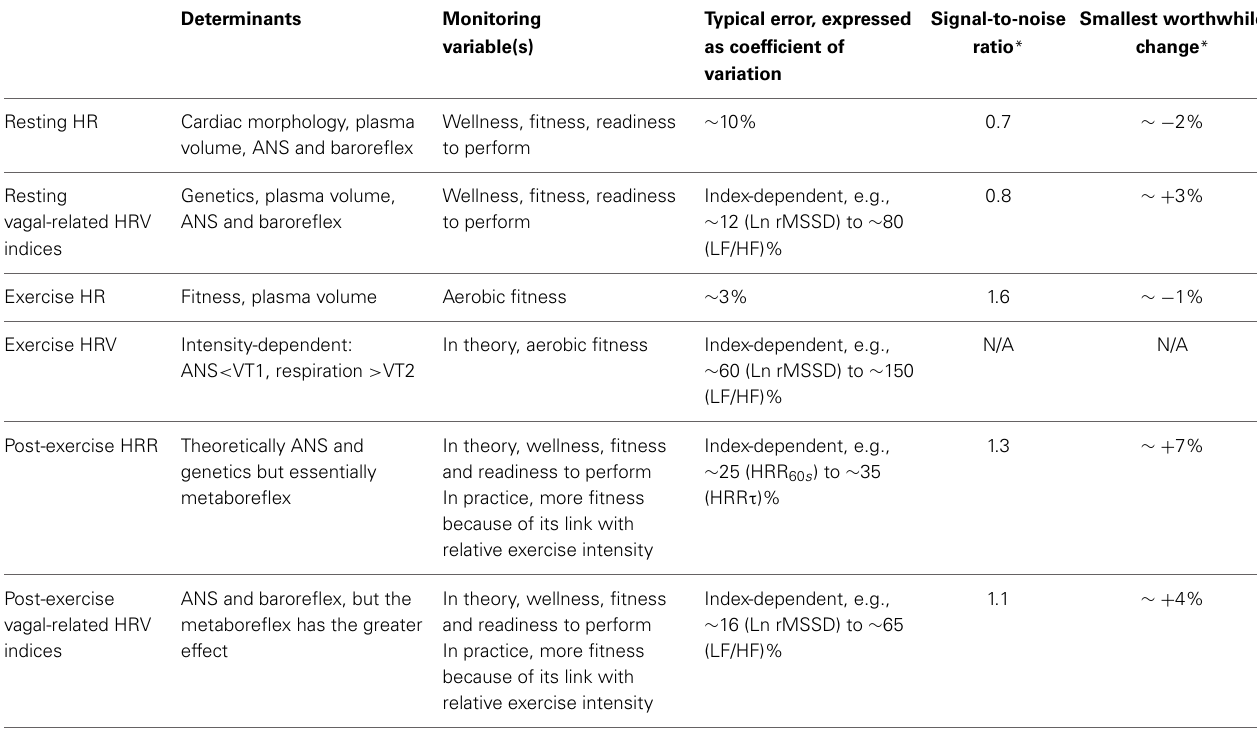
Table 1 | Determinants, reliability and sensitivity of the different heart rate